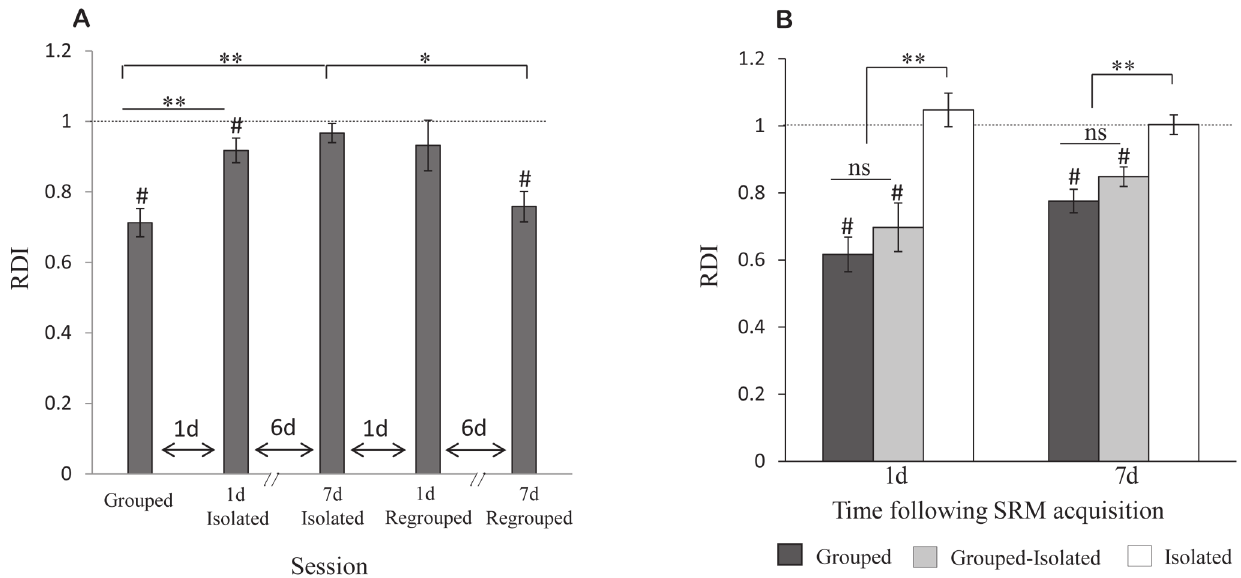
Figure 3. Social isolation rapidly induced a reversible impairment in consolidation of long-term SRM (mean ± SEM). A) RDI values of two 5 min encounters, 120 min apart, with the same juvenile. This test was repeated with the same group of adult animals (n=13) while their housing conditions were changed, using new stimuli for every session. Long-term SRM was confirmed for every session if a paired t-test found a significant reduction in SIT between the first and second ( # p , 0.05). After isolation for 1 day (1 d isolated) the rats showed a significant increase in their RDI values from when they were housed in groups (Grouped) and following 7 days of isolation (7 d isolated) the rats were unable to acquire long-term SRM. This effect was reversed following 7 days (7 d Regrouped), but not 1 day (1 d Regrouped) of return to group housing. Repeated ANOVA, F (4,48) =6.96, p , 0.001, Bonferroni post hoc : * p , 0.05, ** p , 0.01. B) RDI values of 5 min encounters with the familiar and a novel juvenile 30 min apart, 1 d (left) and 7 d (right) after three consecutive 5 min encounters with the familiar juvenile (retroactive facilitation, Fig. 1B). Male rats from group housing, isolated immediately after the retroactive facilitation (Grouped-Isolated, light gray bars), displayed SRM both 1 day and 7 days later, as did males kept in group housing throughout the experiment (Grouped, dark gray bars). In contrast, rats kept in solitary cages for 7 days before SRM acquisition and throughout the experiment (Isolated, empty bars) did not retain the memory even for 1 day. Long-term SRM was assessed by paired t-test ( # p , 0.05) on SIT values between the encounters with the familiar and the novel juvenile. For both 1 day and 7 days intervals no statistically significant difference in RDI was found between Grouped and Grouped-Isolated animals, whereas Isolated rats differed from the other two groups (1-way ANOVA, 1 d: F (2,21) =14.9 p =0.001; 7 d: F (2,21) =13.7, p , 0.001, Bonferroni post hoc : ** p , 0.01, n=8 per